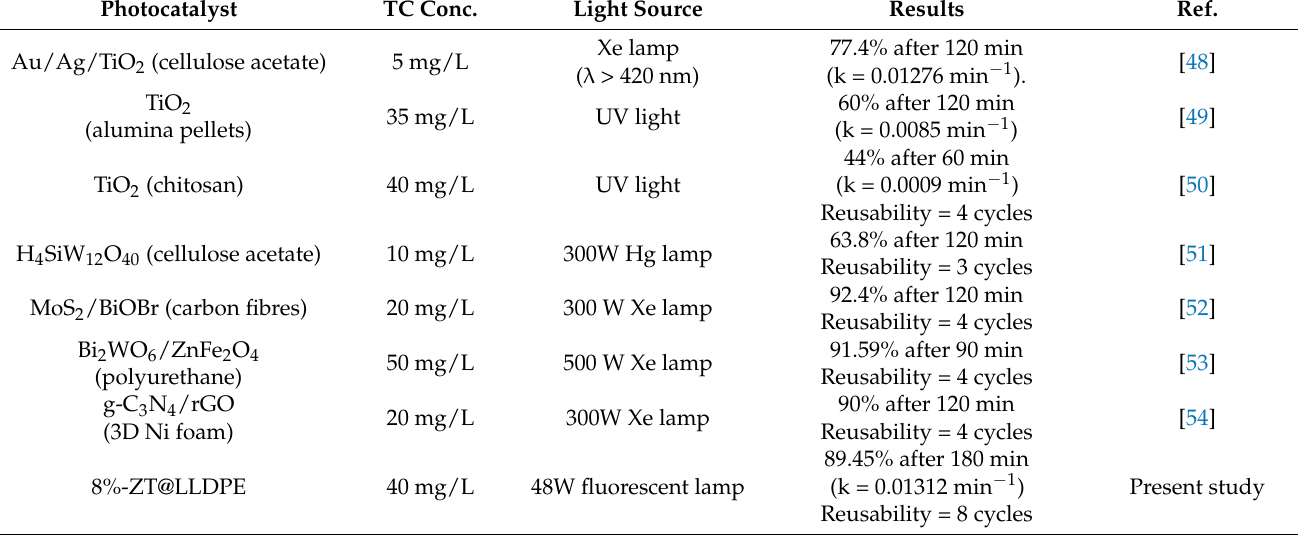
Table 2. Comparison of recently reported studies on immobilised photocatalysts with the present study on the degradation of TC. Photocatalyst TC